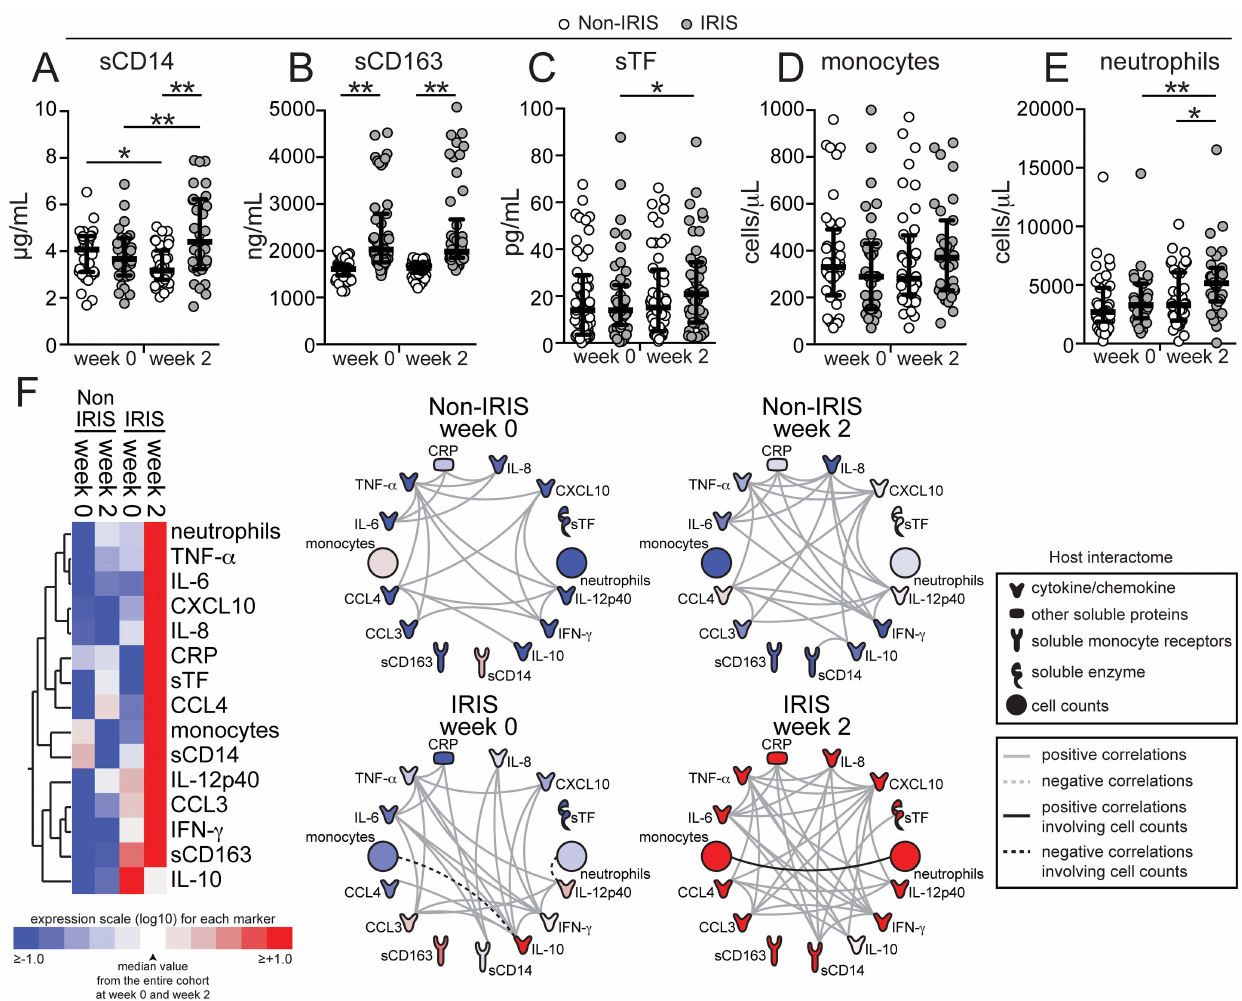
Figure 4. TB-HIV co-infected patients from South Africa exhibited a similar inflammatory biomarker pattern of paradoxical TB-IRIS as well as a lack of correlation between monocyte counts and soluble biomarkers of inflammation. ( A–D ) Plasma levels of sCD14 ( A ), sCD163 ( B ), sTF ( C ), absolute monocyte count ( D ), and absolute neutrophil counts ( E ) were compared at week 0 (pre-ART) and at week 2 after ART initiation between TB-HIV co-infected patients that developed paradoxical TB-IRIS (n=44) and those who did not (n=52). Lines represent median values and interquartile ranges. Data were analyzed using the Mann-Whitney test or Wilcoxon matched-pairs test for paired comparisons within each study group. * P , 0.05, ** P , 0.01. ( F ) Left panel: A Heat map was designed to depict the overall pattern of expression of plasma cytokines, chemokines and inflammatory biomarkers in IRIS vs. non-IRIS patients at week 0 (pre-ART) and at week 2. A two-way hierarchical cluster analysis (Ward’s method) of circulating biomarkers by clinical group and time point was performed. Expression scale for each biomarker represents log 10 fold- change from the geometric mean of the entire study population at week 0 and week 2 or the time of IRIS (n=96 at each study time point). Right panel: The network analysis (interactome) shows statistically significant correlations (P , 0.05) between all the parameters measured. Data were analyzed using Spearman rank tests. See Data File S2 for additional details on the strength (r value) and level of significance (P-value) of each individual